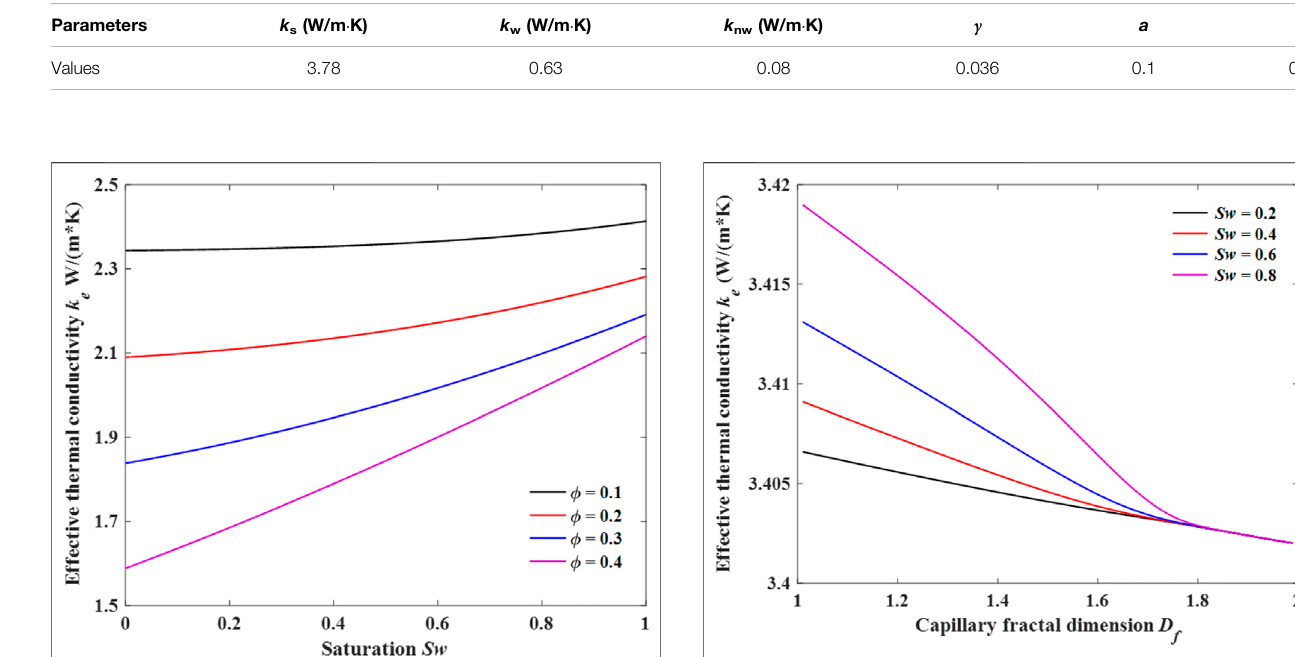
FIGURE 6 | The effect of porosity on the ETC.